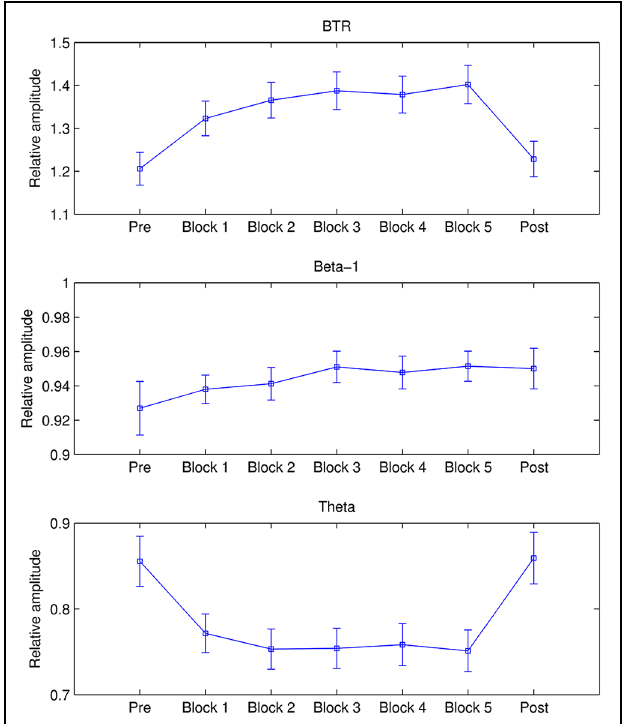
FIGURE 1 | Mean BTR, beta-1, and theta in each period. The error bars depict standard error of the mean (SEM).